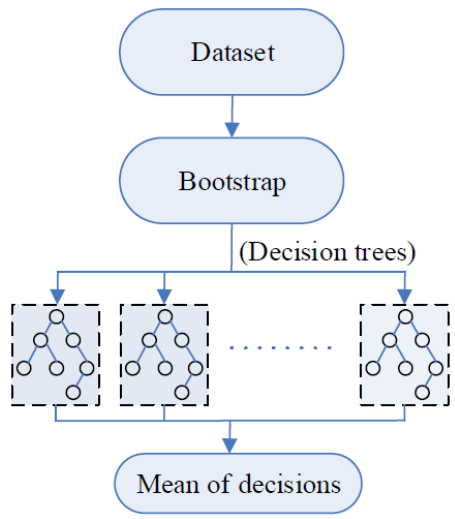
Figure 1. The Random forest models [40].